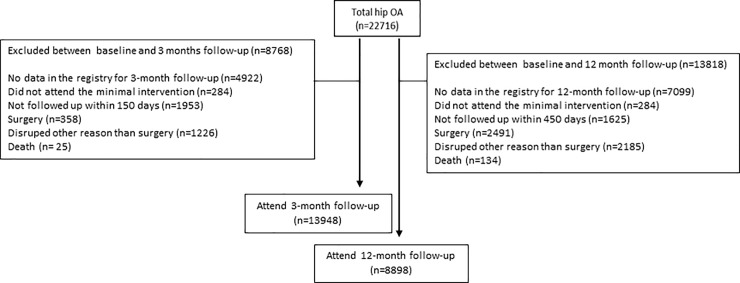
Flowchart of the study, knee OA.